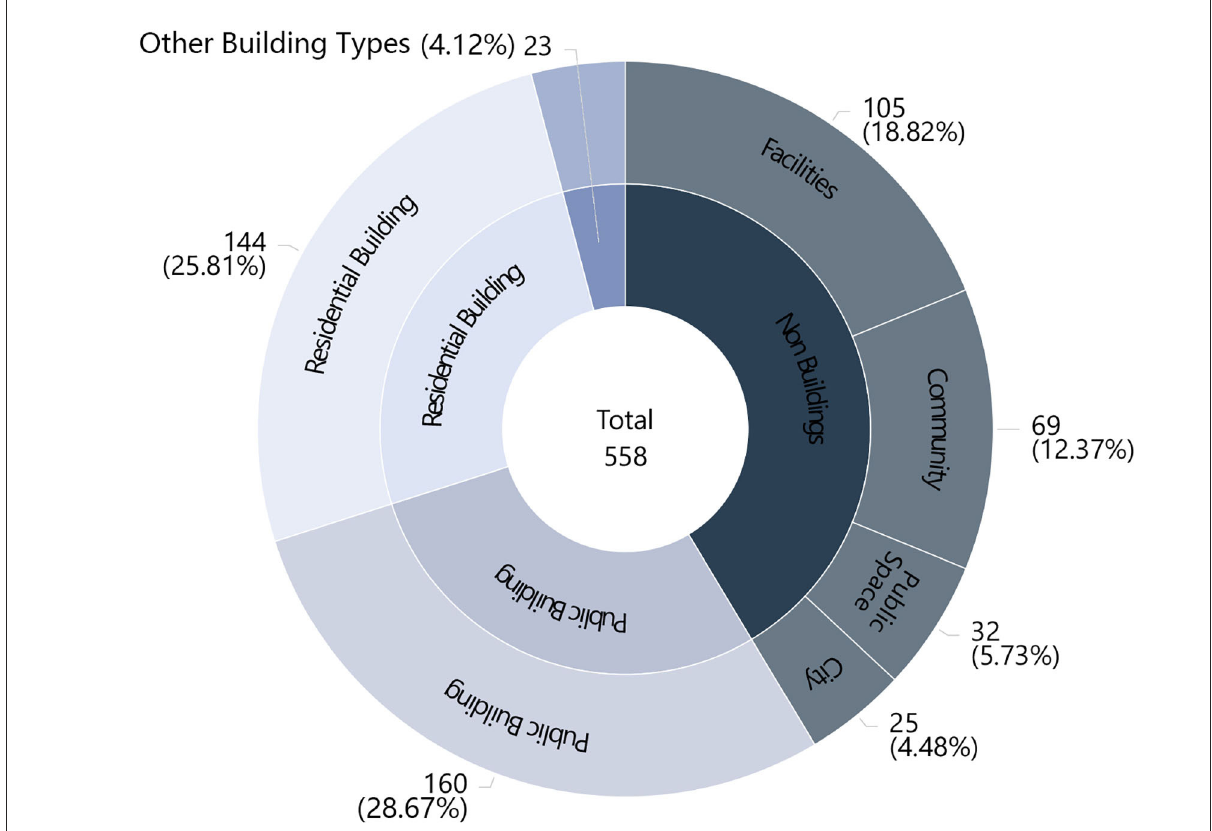
FIGURE3 Distribution of building